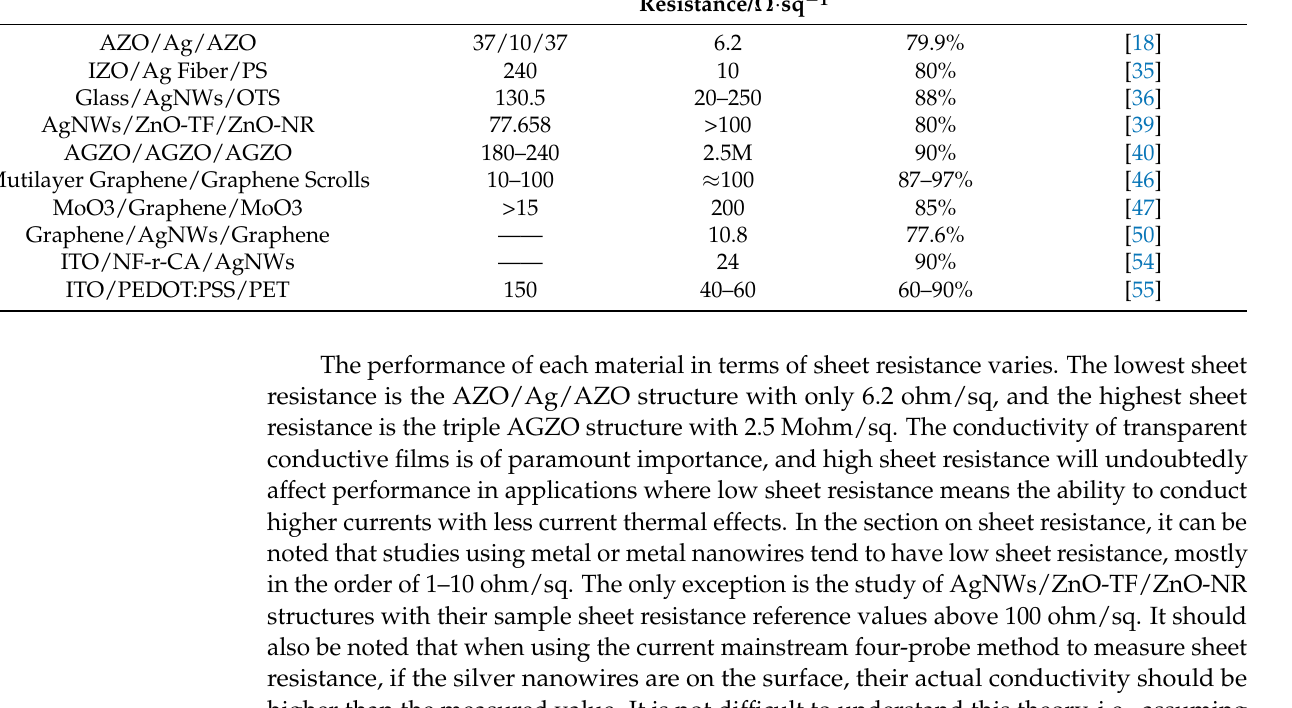
Table 1. Summary of the thickness, sheet resistance, and light transmission of some studies.